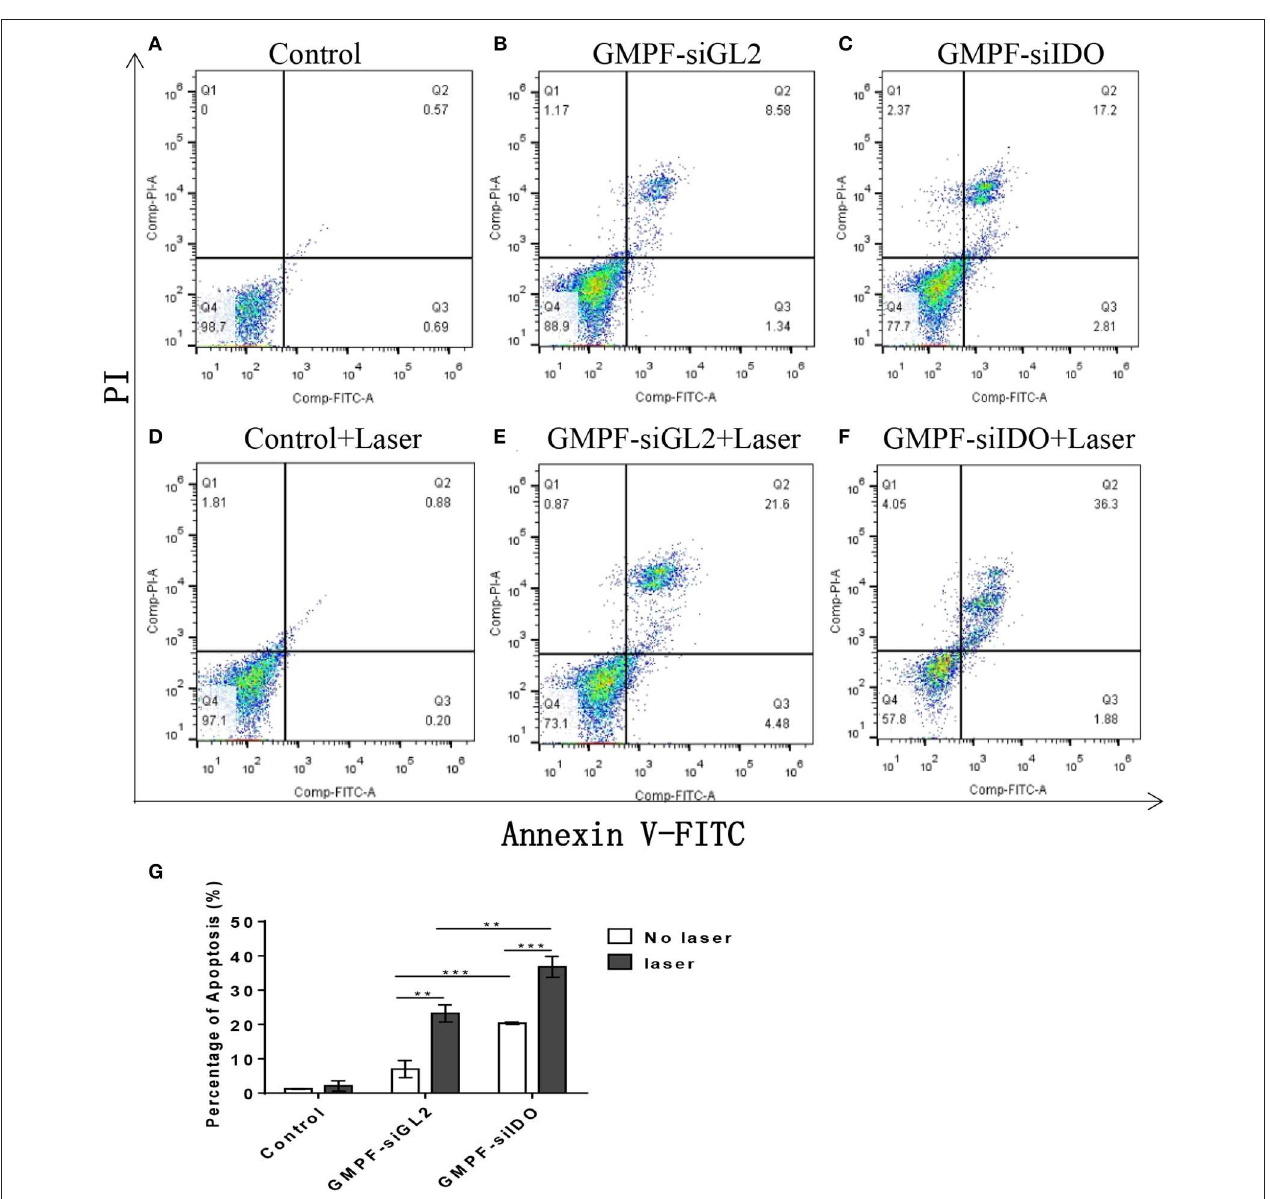
FIGURE 3 | Assessment of tumor cell apoptosis by photo-thermal effects of GMPF-siIDO in vitro . LLC cells were incubated with 40 µ g/mL of GMPF-siGL2 or GMPF-siIDO overnight, and samples were then irradiated at 2 W/cm 2 for 5min. The apoptotic cell distribution of all was determined at 24h using the Annexin V-FITC/PI Apoptosis Detection Kit and analyzed by flow cytometry (A–F) , and the percentages of apoptosis are (G) . Error bars represent the standard divination of three experiments (** p < 0.01; *** p < 0.001).